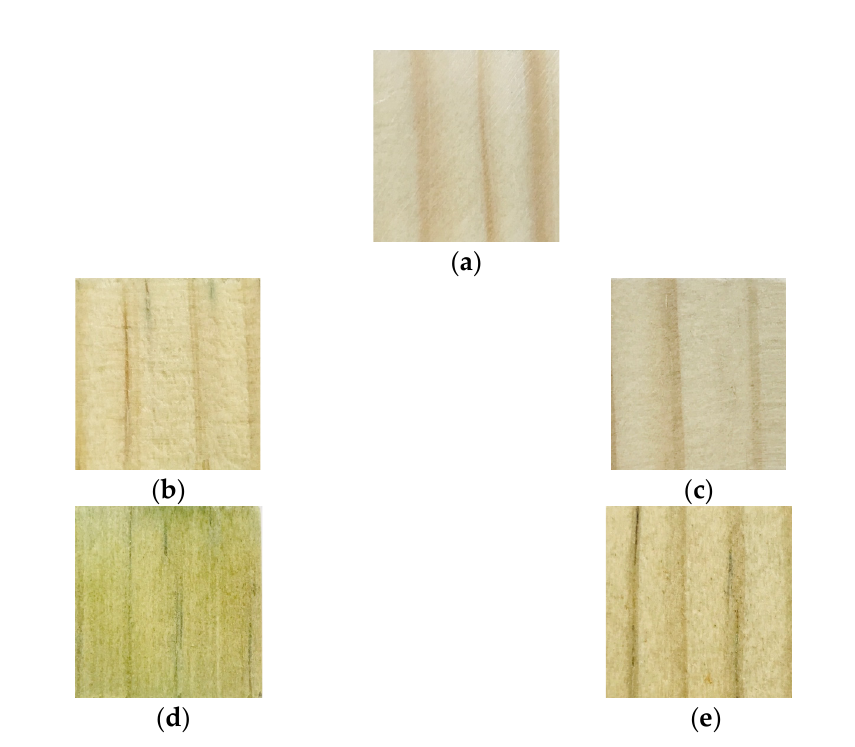
Figure 4. Photographs of control, impregnated, and leached radiata pine wood samples. ( a ) Control sample; ( b ) group A, wood impregnated with CuNP 1 g/L and ( c ) leached; ( d ) group B, wood impregnated with CuNP 3 g/L and ( e ) leached.